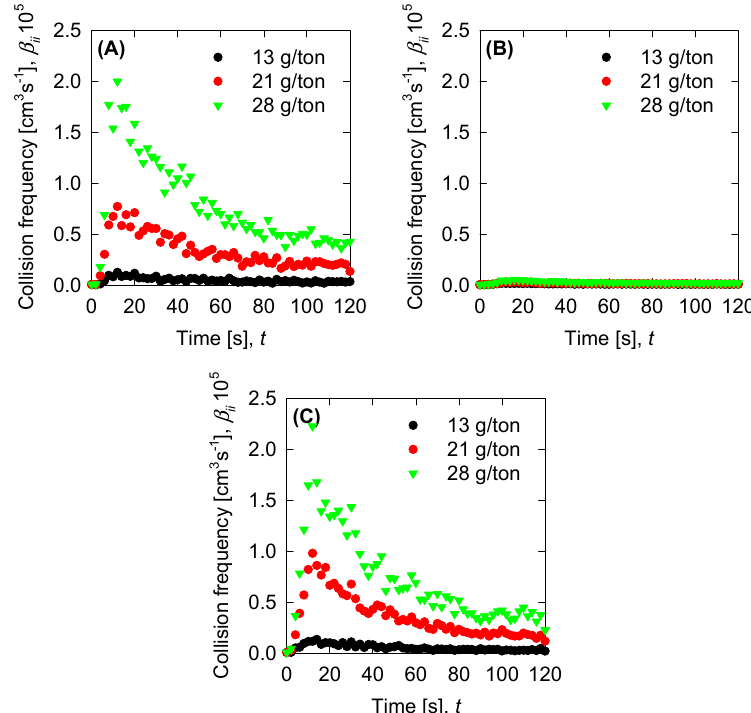
Figure 7. Collision frequency for the experimental data for ( A ) SW pH 8, ( B ) SW pH 11, and ( C ) T-SW pH 11.